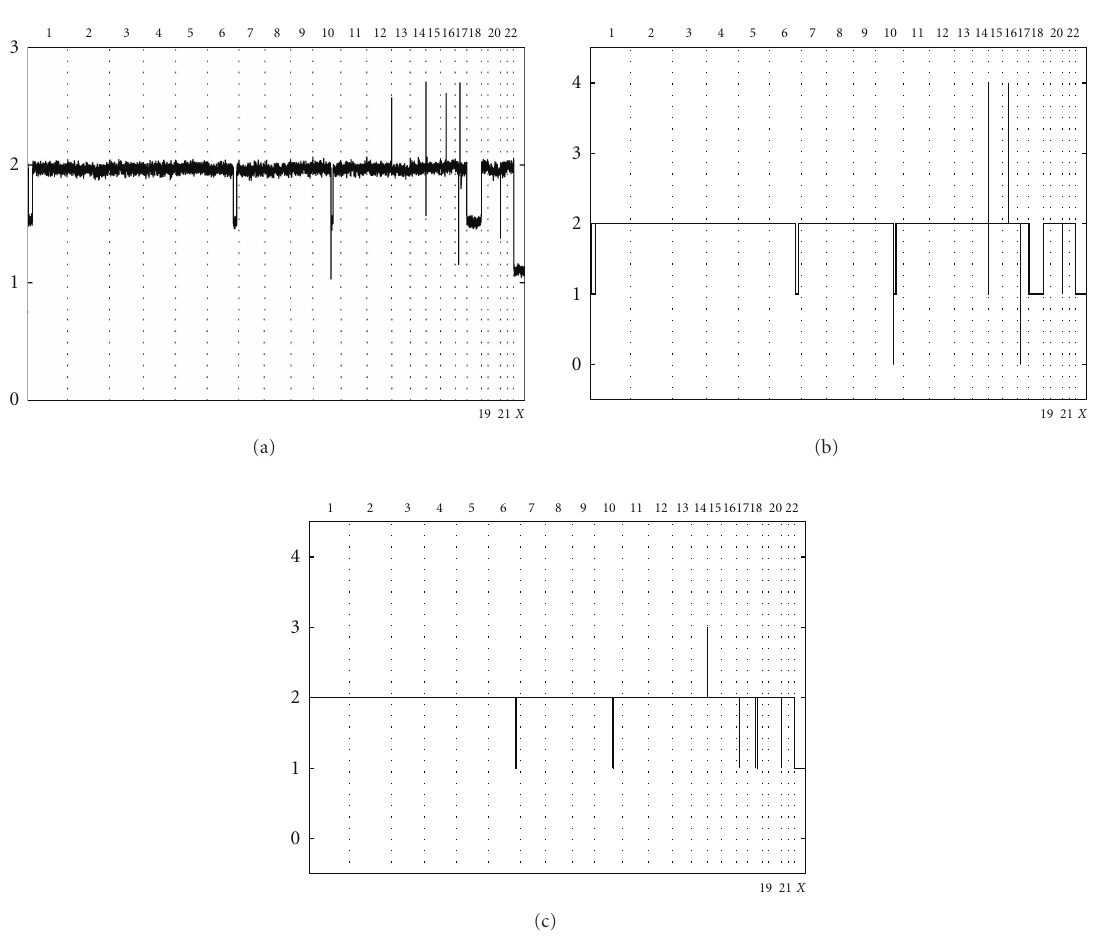
Figure 4: Results of CN analysis of colon tumor sample (collected from male subject) significantly contaminated with benign tissue ( ∼ 48%). (a) Signal intensity of SNPs ( y axis) for this sample after adjustment on genome size but before adjustment on contamination with benign tissue. (b) Correct CN solution for this sample after adjustment on both genome size and contamination with benign tissue. (c) Incorrect CN solution for this sample after adjustment on genome size but without adjustment on contamination with benign